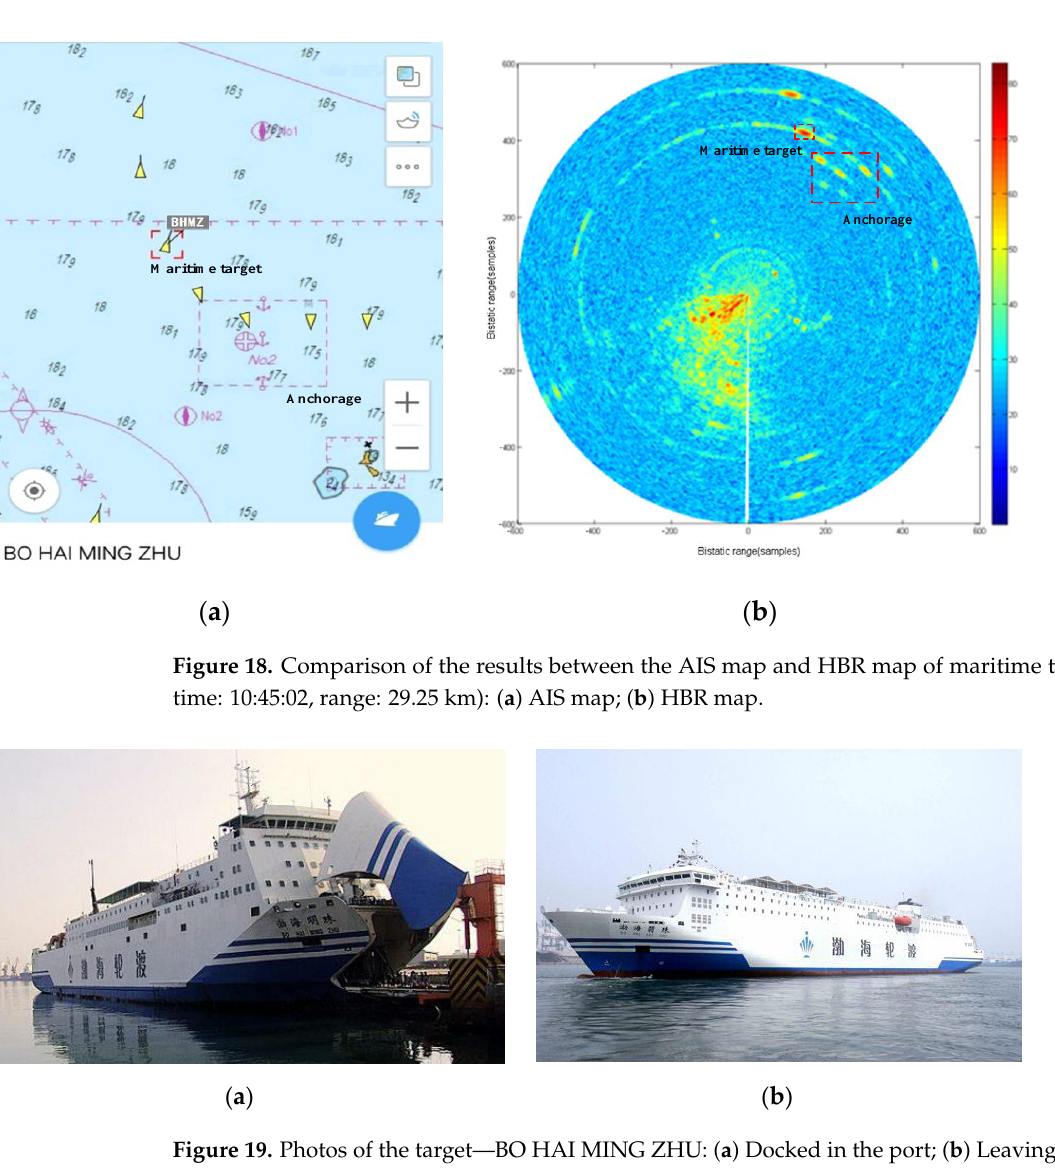
Figure 19. Photos of the target — BO HAI MING ZHU: ( a ) Docked in the port; ( b ) Leaving the port.